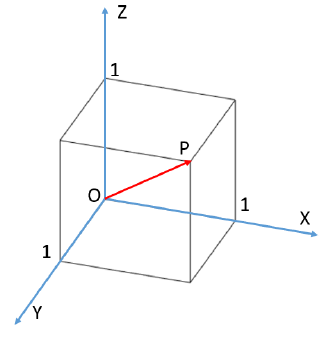
Figure 8. The XYZ coordinate system of the system.